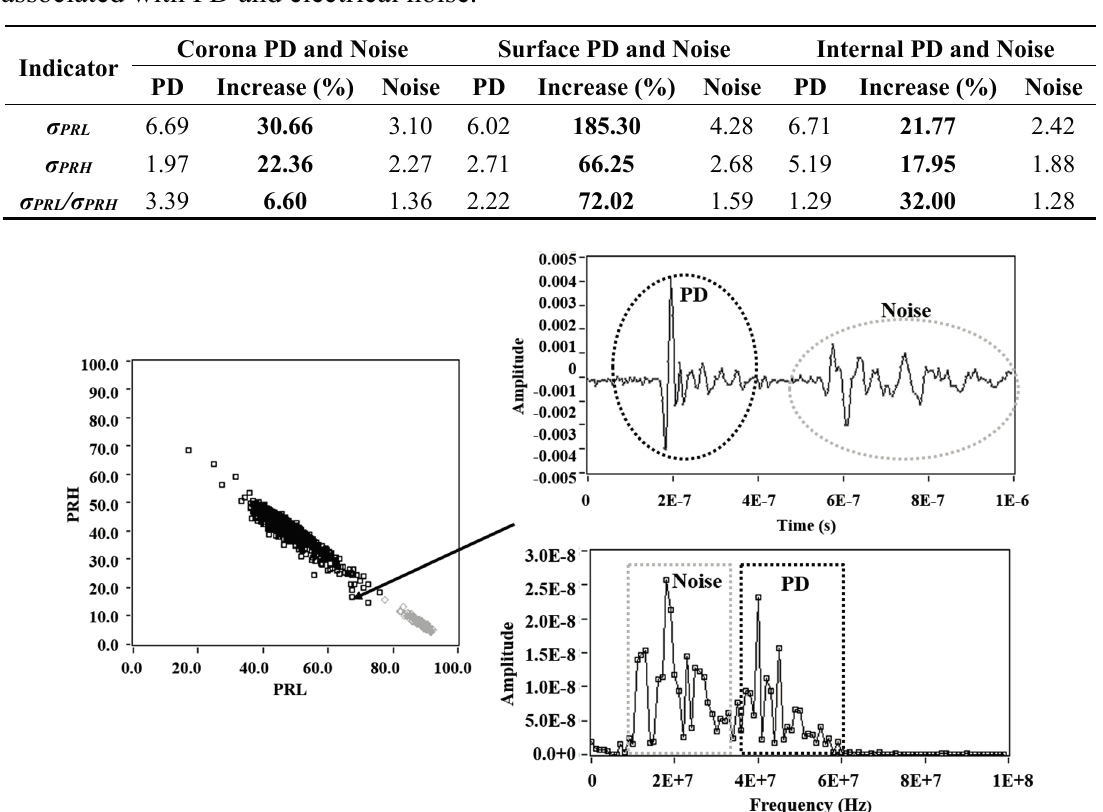
Figure 9. Example of a pulse formed by components of PD and